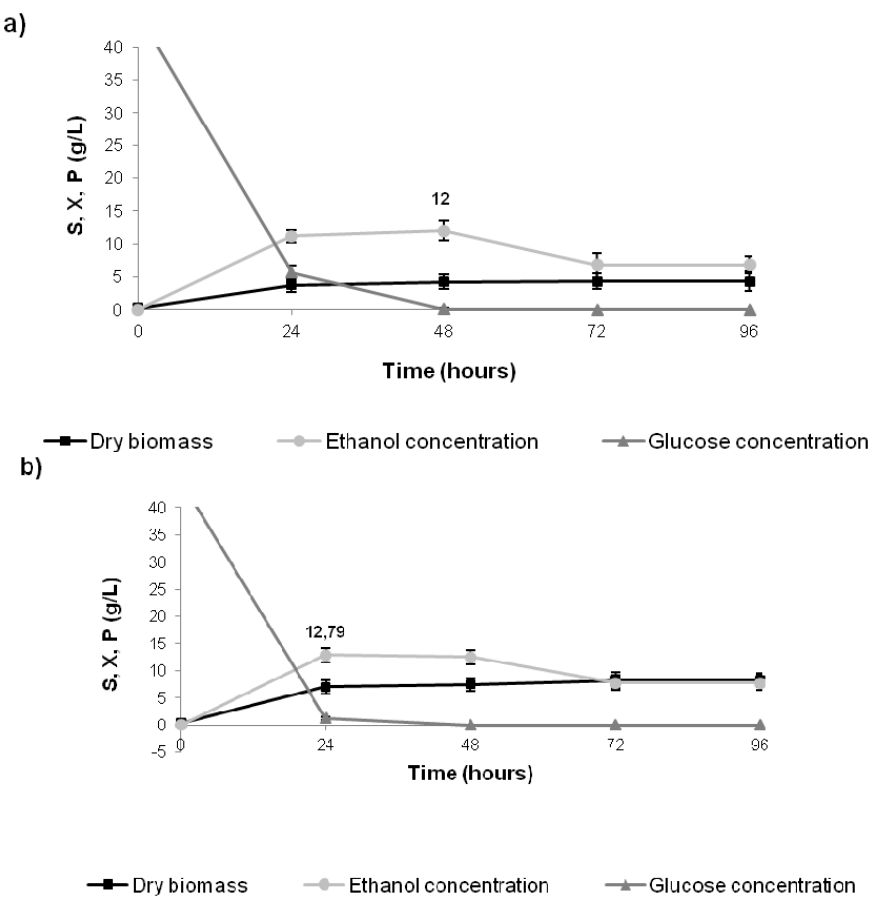
Figure 1. Fermentation of glucose to ethanol by Saccharomyces cerevisiae NRRL YB 2293 in ( a ) BSG hydrolysate and ( b ) BSG hydrolysate + yeast extract; glucose concentration ( S , ∆ ), dry biomass concentration ( X , □ ) and ethanol concentration ( P , ○ ). All values are mean of two independent